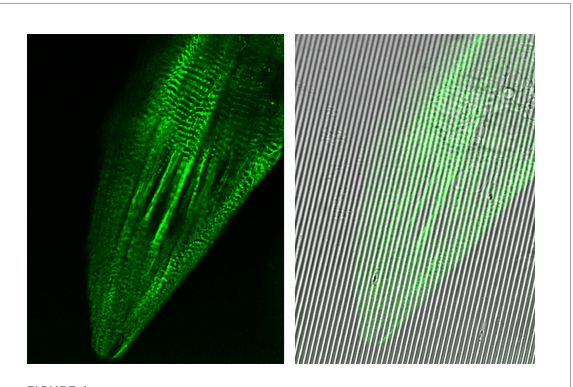
FIGURE4 Images captured at 100 × oil immersion objective using Leica Sp8 Confocal microscope. hiPSC-derived cardiomyocytes (CMs) expressing mEGFP-labeled α -actinin-2 at sarcomeric z-disks (cell line ID: AICS-0075 cl.85) replated on Curi